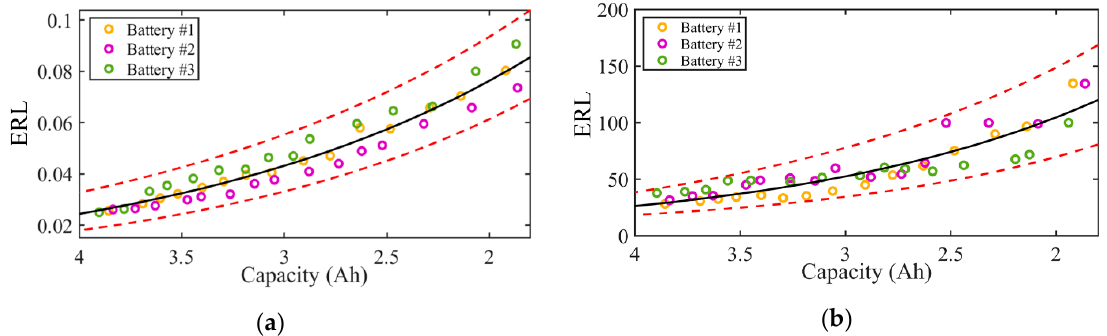
Figure 4. Relationship between excitation response level (ERL) and capacity: ( a ) a dynamic stress test (DST) profile; ( b ) a constant current (CC) profile.